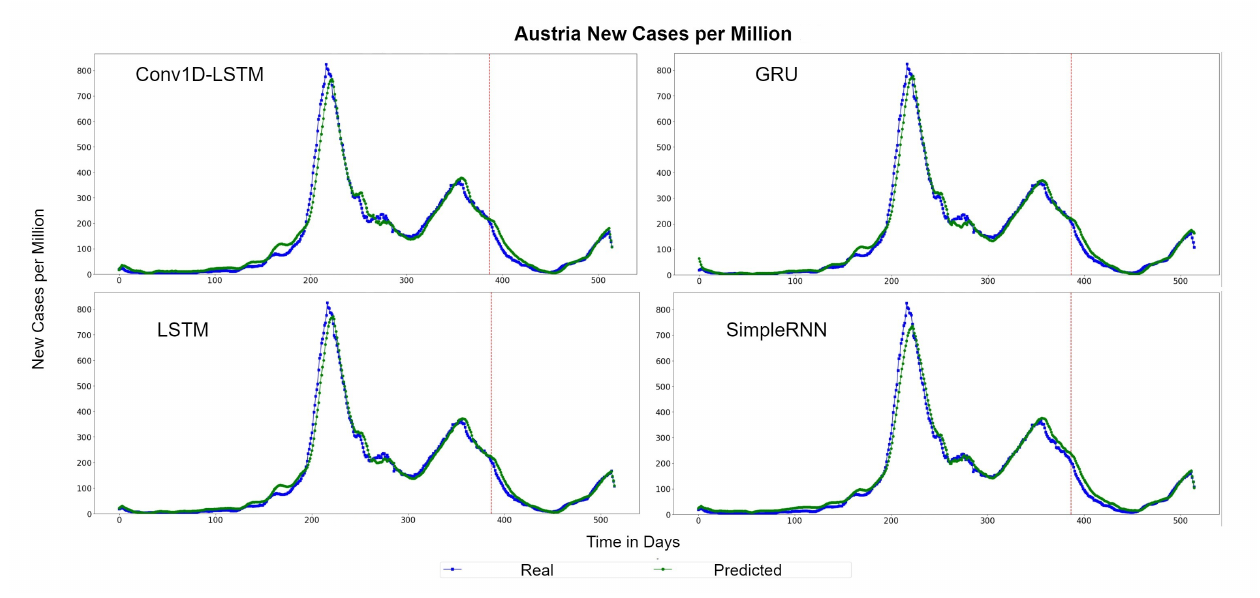
Figure 6. Austria’s new cases per million real (blue line) and predicted (green line) values for each method, using training, validation and test datasets. The red line divides the train-validation (right size) and the test (left side) datasets.